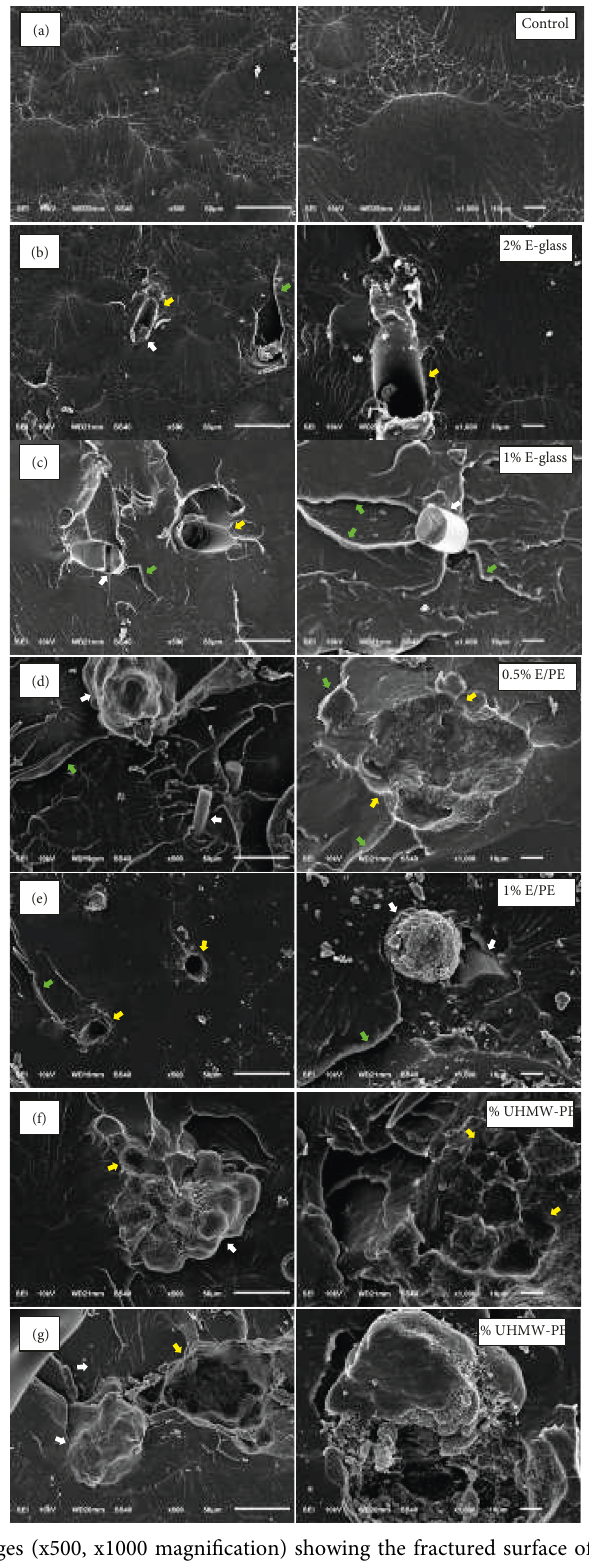
Figure 3: Representative SEM images (x500, x1000 magnification) showing the fractured surface of (a) self-cured acrylic resin (control group 1). (b) 2% short E-glass fiber reinforced self-cured acrylic resin (group 2). (c) 1% short E-glass fiber reinforced self-cured acrylic resin (group 3). (d) 0.5% short E-glass fiber/ultra-high-molecular-weight polyethylene filler-reinforced self-cured acrylic resin (group 4). (e) 1% short E-glass fiber/ultra-high-molecular-weight-polyethylene filler-reinforced self-cured acrylic resin (group 5). (f) 1% ultra-high-mo- lecular-weight polyethylene filler-reinforced self-cured acrylic resin (group 6). (g) 2% ultra-high-molecular-weight polyethylene filler- reinforced self-cured acrylic resin (group 7). The white arrow indicates the reinforcement particles, the yellow arrow indicates the area that reinforced particle breakdown or that is dislodged, and the green arrow indicates the area of the cohesive failure of the